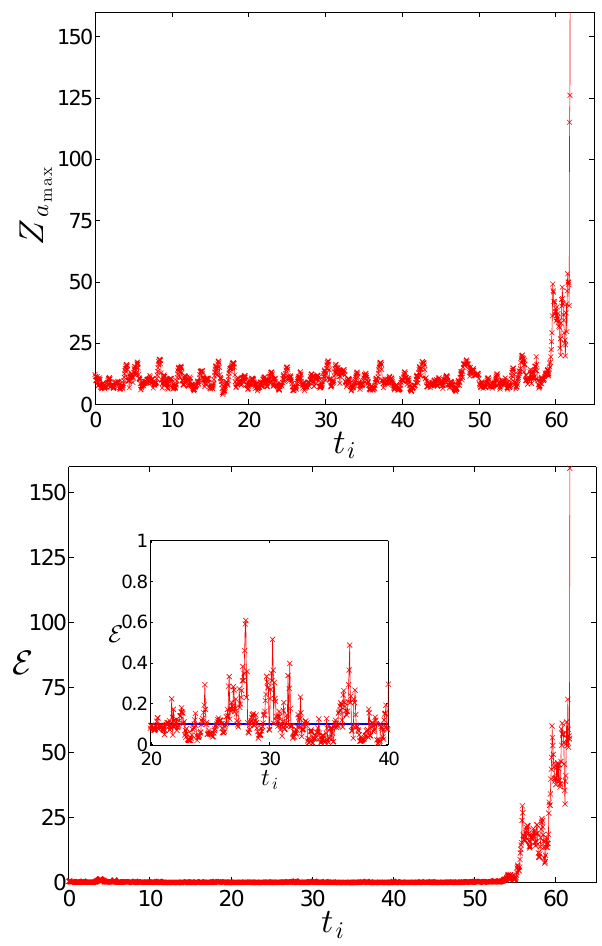
Fig. 1. Top: maximal absolute value Z over all D = 5 components for d t = 0 . 025 and 1t obs = 0 . 05 with R o = 0 . 01 and k = 6 ensemble members. Bottom: the error norm E as a function of analyses cycles. The continuous line (online blue) in the inset shows the observational error